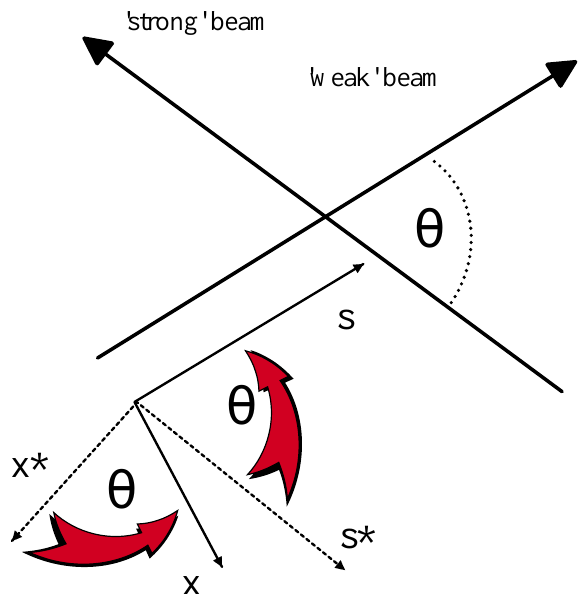
FIG. 1. (Color) Schematic of coordinate system for two beams colliding under a crossing angle u . The s (cid:1) coordinate with asterisk is aligned with the axis of the “strong” beam, but points opposite to its direction of motion. The s coordinate without asterisk refers to the frame of the “weak” beam for which the tune shift is to be calculated. The two frames are related via a rotation in the s - x plane by the angle u . The vertical ( y ) axis is perpendicular to the plane drawn and identical in the two coordinate